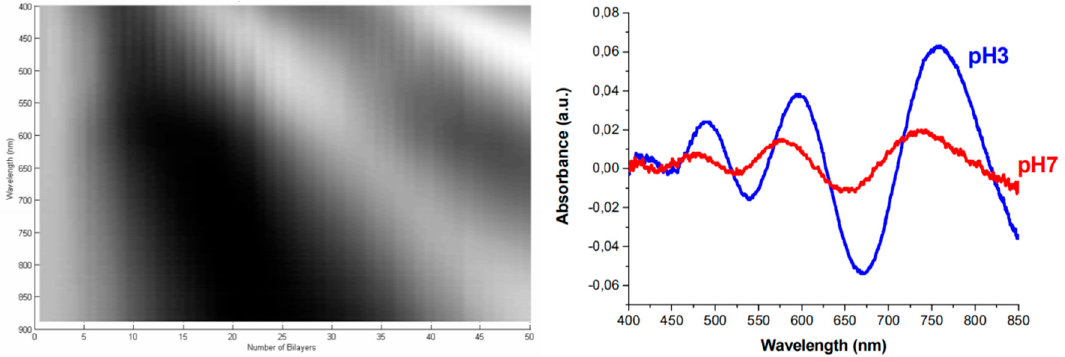
Figure 18. Low coherence white light interferometric Fabry-Perot cavity created using (PAH/PAA) LbL thin films. ( Left ) Evolution of the interference pattern as the number of bilayers is increased, using a halogen lamp as light source. ( Right ) Spectral response of the nano-FP cavity when the optical fiber tip is immersed into different pH solutions. Reprinted with permission from Ref. [105].